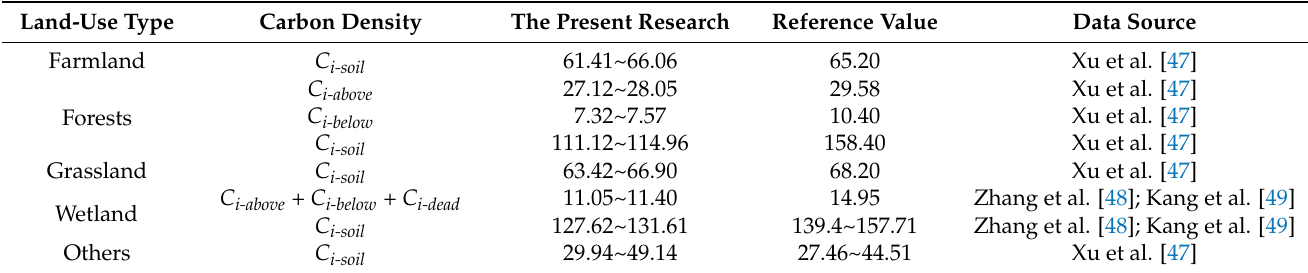
Table 5. Comparison of carbon density of different land-use types (unit: Mg · ha − 1